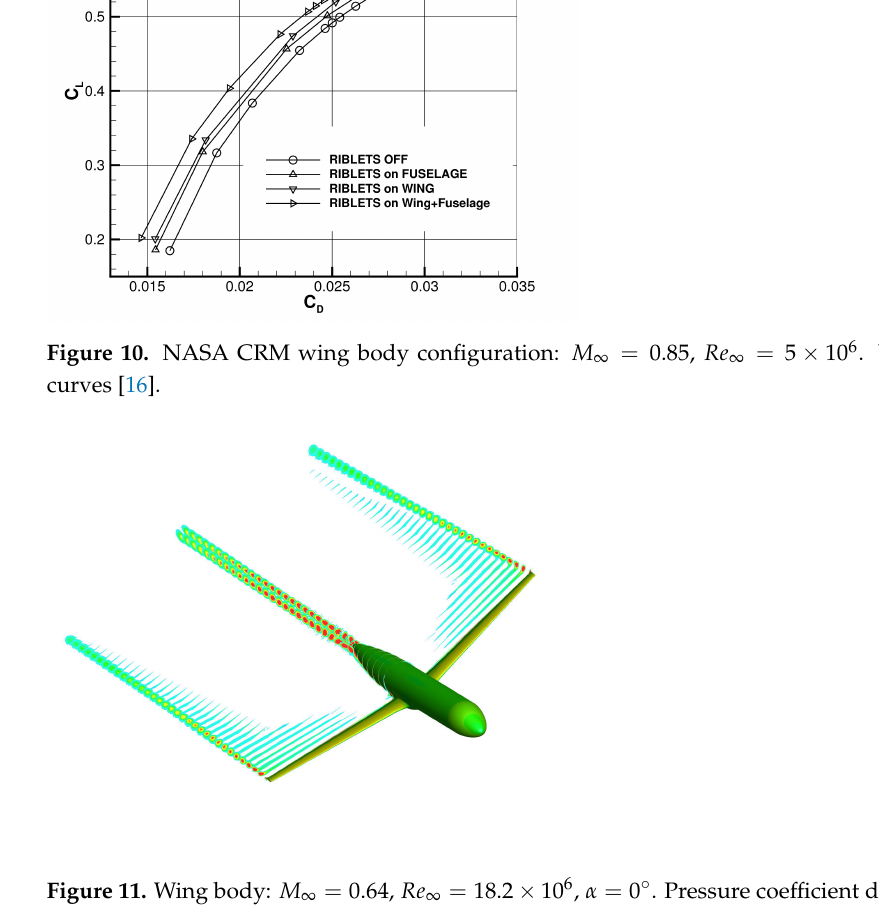
Figure 11. Wing body: M ∞ = 0.64, Re ∞ = 18.2 × 10 6 , α = 0 ◦ . Pressure coefficient distribution and x-vorticity module in the wake [35].